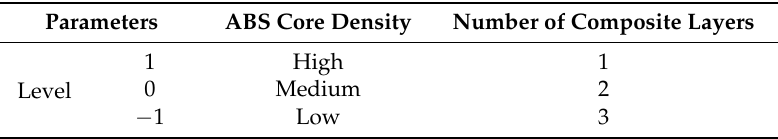
Table 2. Design of Experiment Range